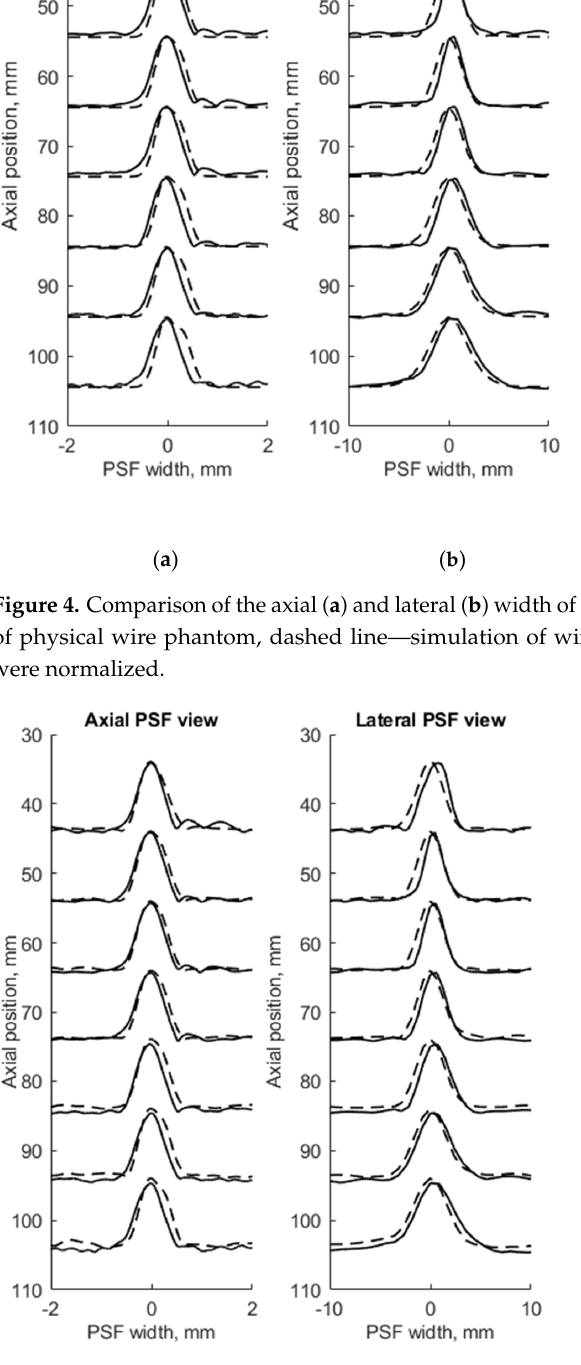
wire phantom by wires.